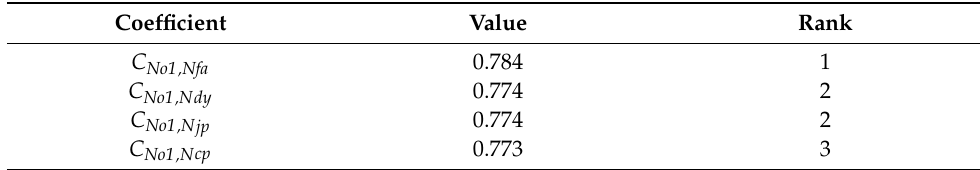
Table 5. Path module correlation coefficients between the new module N o1 and the modules N fa , N dy , N jp and N cp . Compared with the results in Table 3a, the results in this table are more in line with the